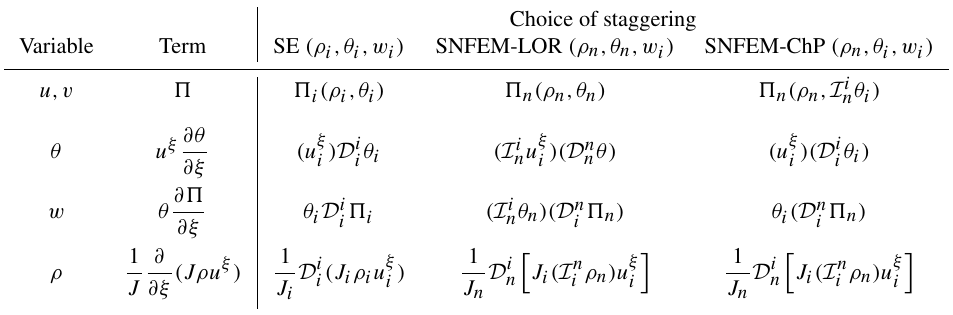
Table 1. Composition of interpolation I and differentiation D operators for several choices of staggering, including collocated spectral elements (SE), SNFEM with Lorenz staggering (SNFEM-LOR), and SNFEM with Charney–Phillips staggering (SNFEM-ChP). Script i denotes variables defined on interfaces (Gauss–Lobatto nodes) and n represents variables defined on model levels (Gauss nodes). For operator I and D , the subscript denotes the target ( i or n ) and the superscript denotes the origin. Choice of